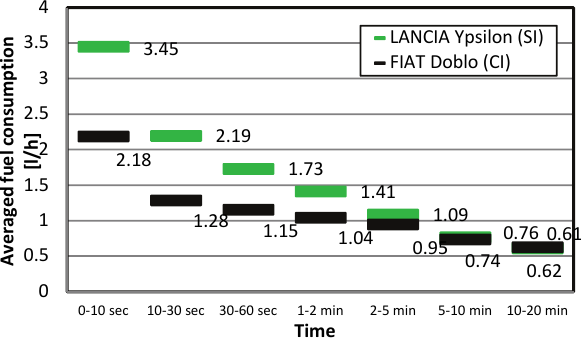
Fig. 7. Averaged fuel consumption at the temperature 0°C